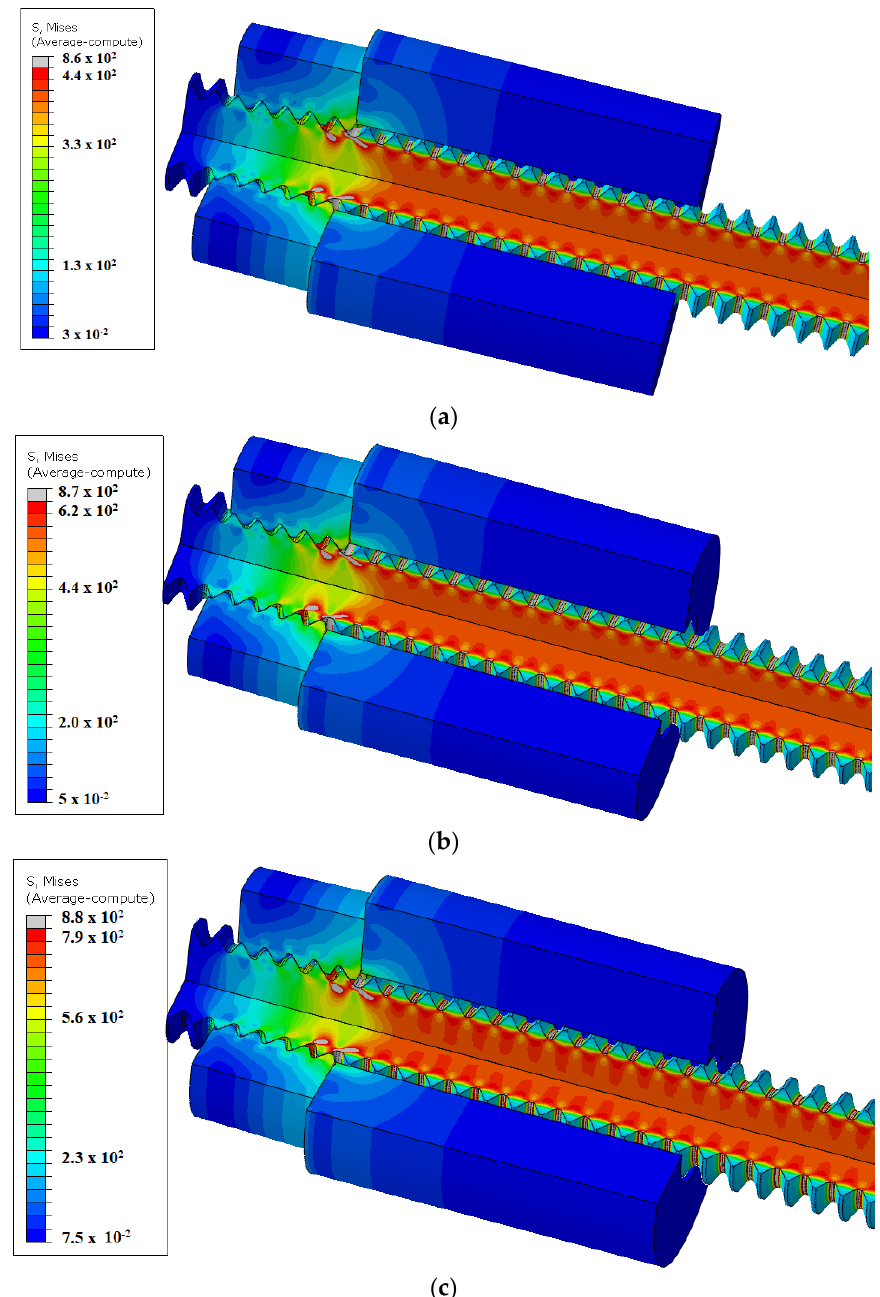
Figure 10. FEA for studs with nut interface. The von Mises stress (MPa) is shown for maximum nominal stress of ( a ) 440.6 MPa (50% of the yield strength), ( b ) 616.8 MPa (70% of the yield strength), and ( c ) 793 MPa (90% of the yield strength).